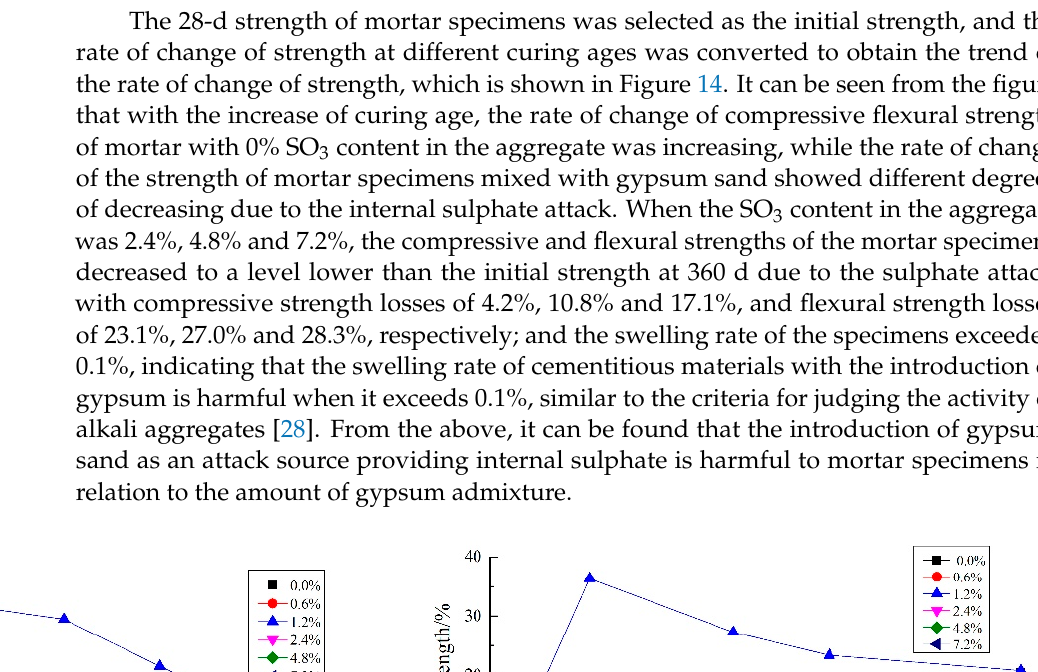
3 content in aggregate.